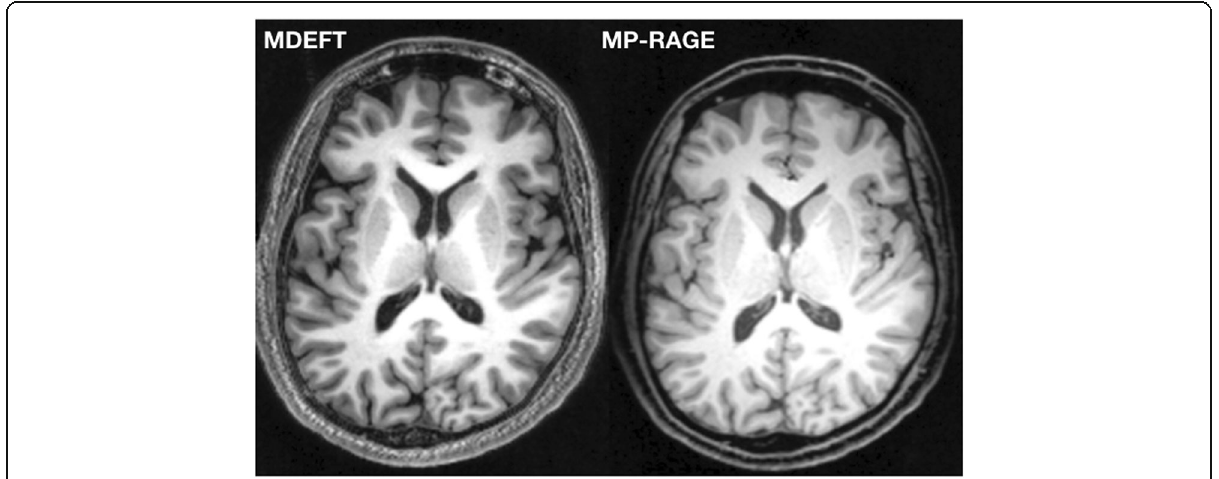
Fig. 1 Two different MR pulse sequences were applied to acquire high-resolution 3D T1-weighted images: MP-RAGE and MDEFT pulse